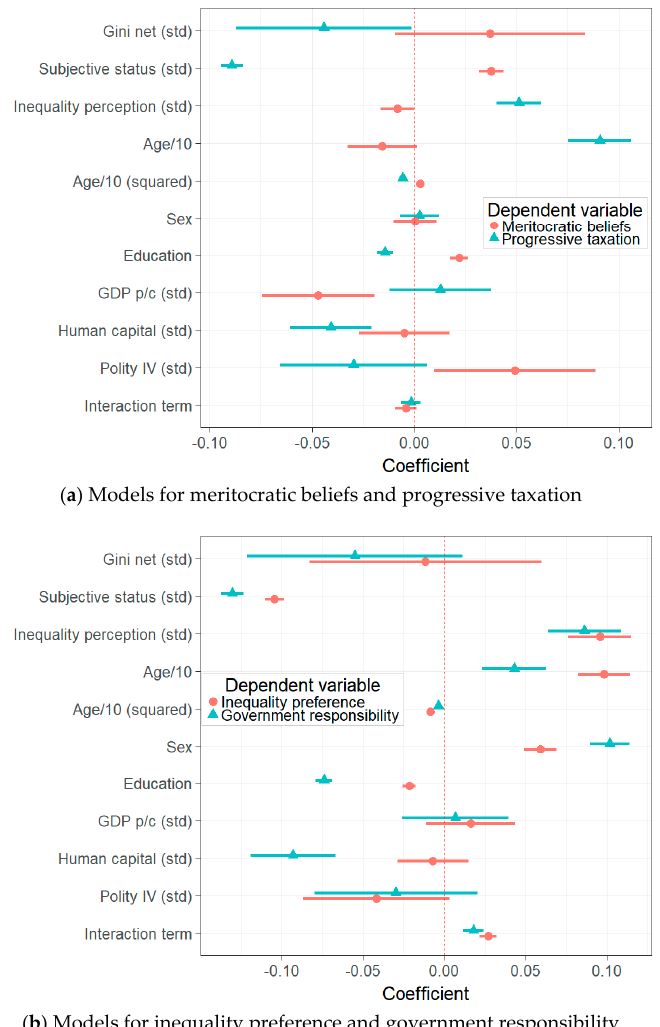
Figure 2. Fixed effect coefficients from varying-intercept, varying-slope models of meritocratic beliefs and progressive taxation ( a ), and inequality preference and government responsibility ( b ).